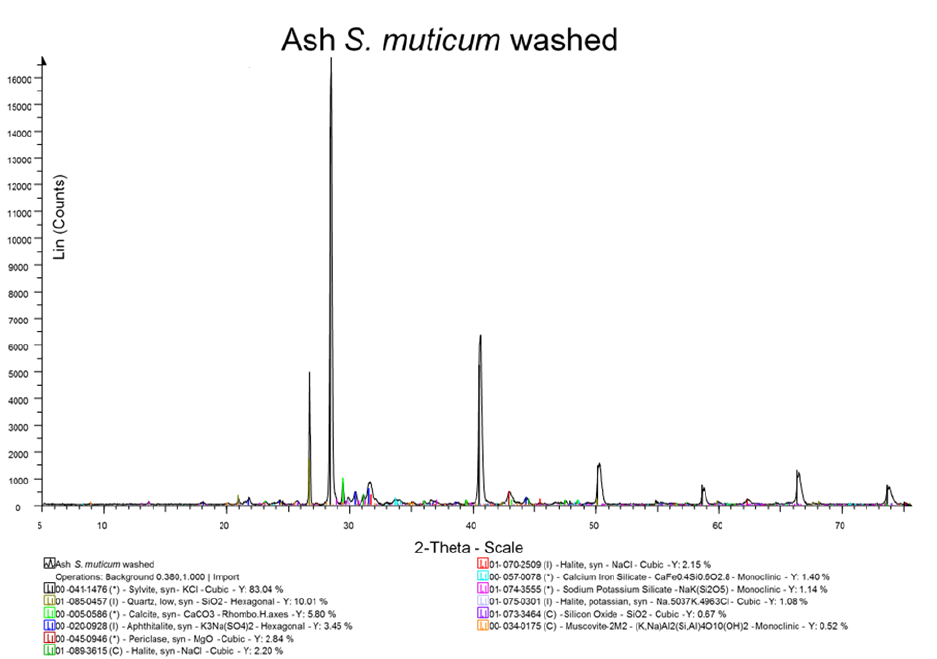
Figure 2 . XRD analysis of unwashed Sargassum muticum .